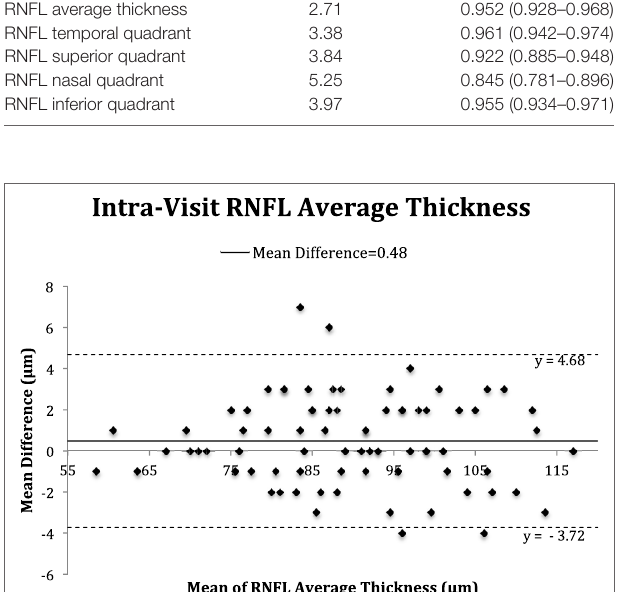
FigUre 4 | Bland–Altman plot of intra-visit macular ganglion cell-inner plexiform layer (GC-IPL) average thickness.